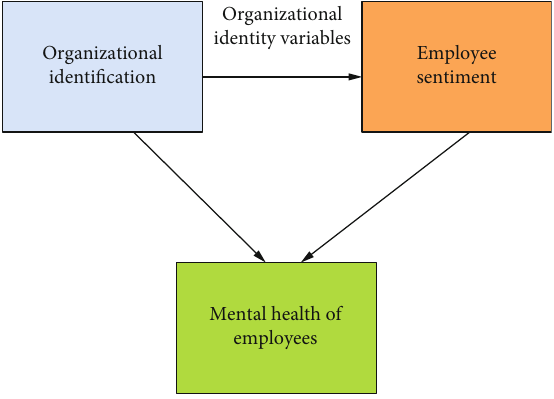
Figure 1: The theoretical research